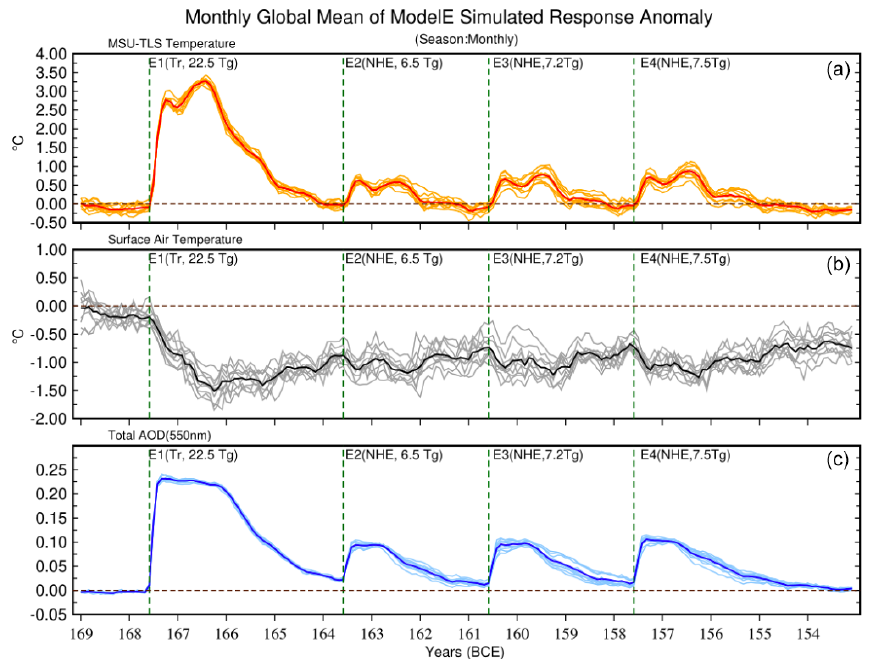
Figure 5. Globally averaged changes in microwave sounding unit (MSU) temperature for the lower stratosphere (TLS) (a) , surface air temperature (b) , and total atmospheric column AOD (c) at 550nm for each month for the entire simulation period. The light-colored solid lines represent individual ensemble members, and the solid dark colors show the ensemble means. The green vertical dashed lines show when the modeled eruptions happened.